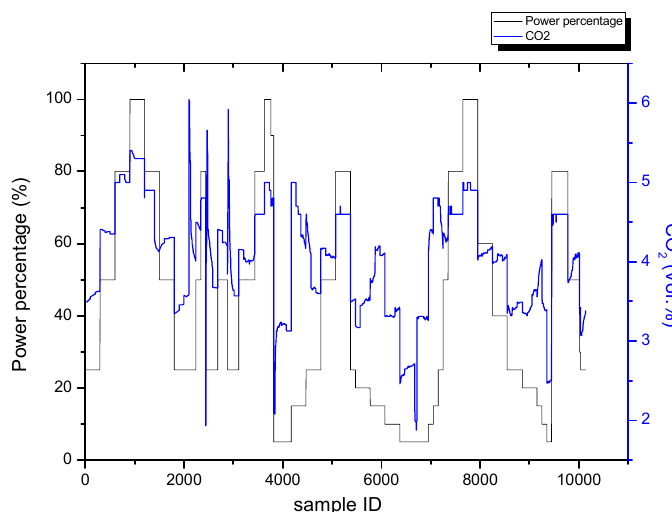
Atmosphere 2020 , 11 , x FOR PEER REVIEW Figure 5. Changes in CO 2 concentration and engine load with time. Figure 5. Changes in CO 2 concentration and engine load with time.